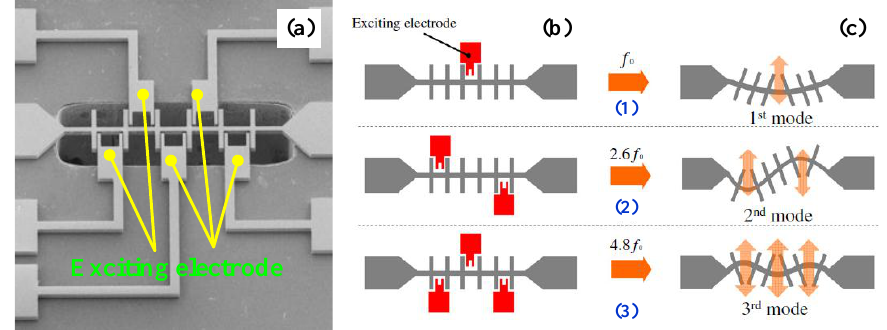
Figure 11. Frequency tuning principle of a fishbone resonator with five exciting electrodes reported by Suzuki et al . [129]. ( a ) SEM of a fishbone micromechanical resonator with five exciting electrodes; ( b ) Configurations of the exciting electrodes; ( c ) main beam deformations corresponding to each exciting electrode configuration. Reused with permission from